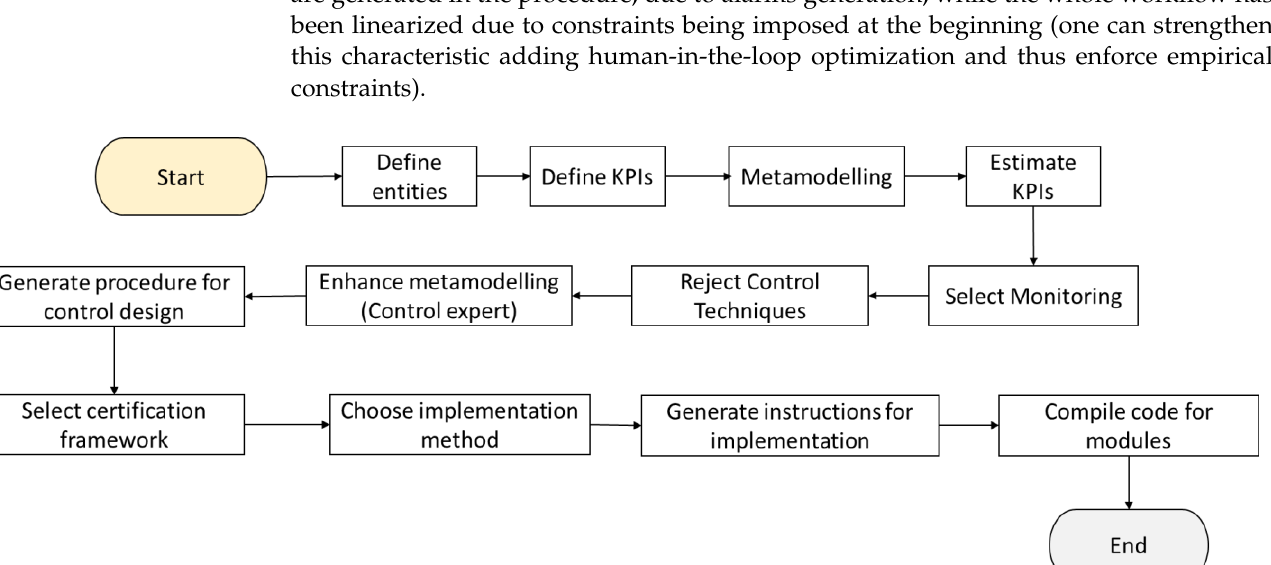
Figure 11. Updated workflow for process monitoring/control taking into account metamodelling.